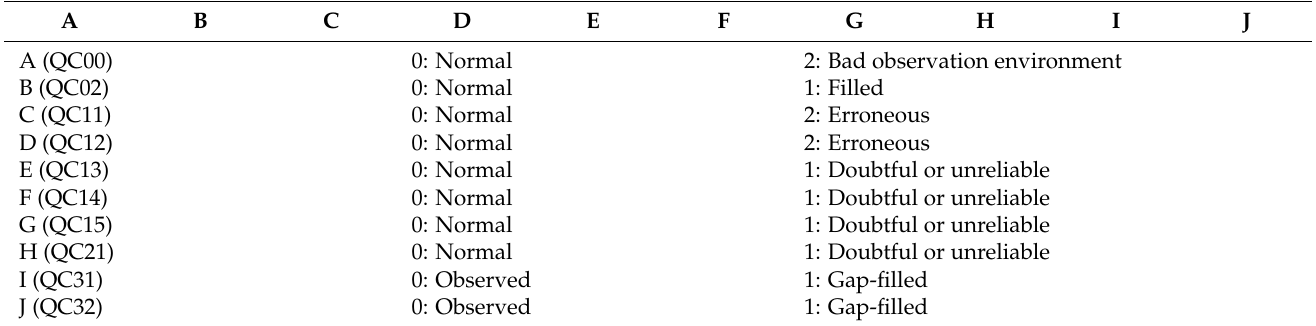
Table 6. Flag rules for